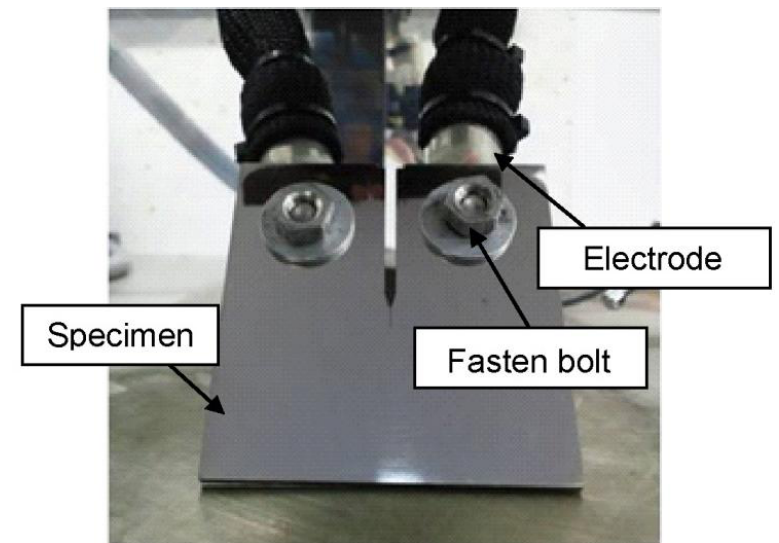
Figure 3. Photograph of the electropulsing set-up.